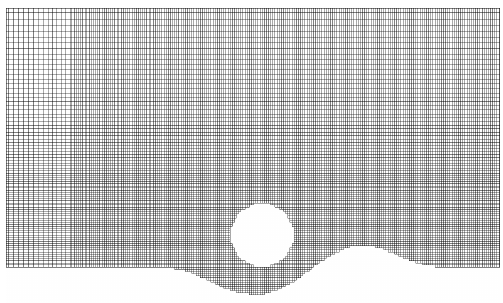
Figure 8. Close-up side views of the fluid mesh cells near the cylinder and bed profile 3.